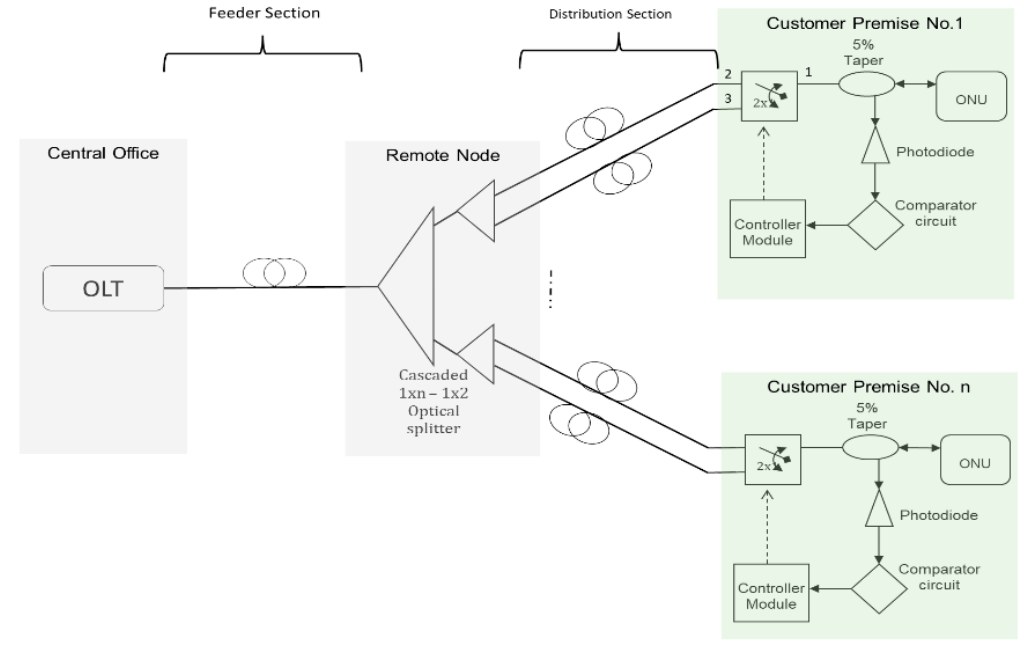
Figure 7. Proposed protection and restoration scheme with PROMO.